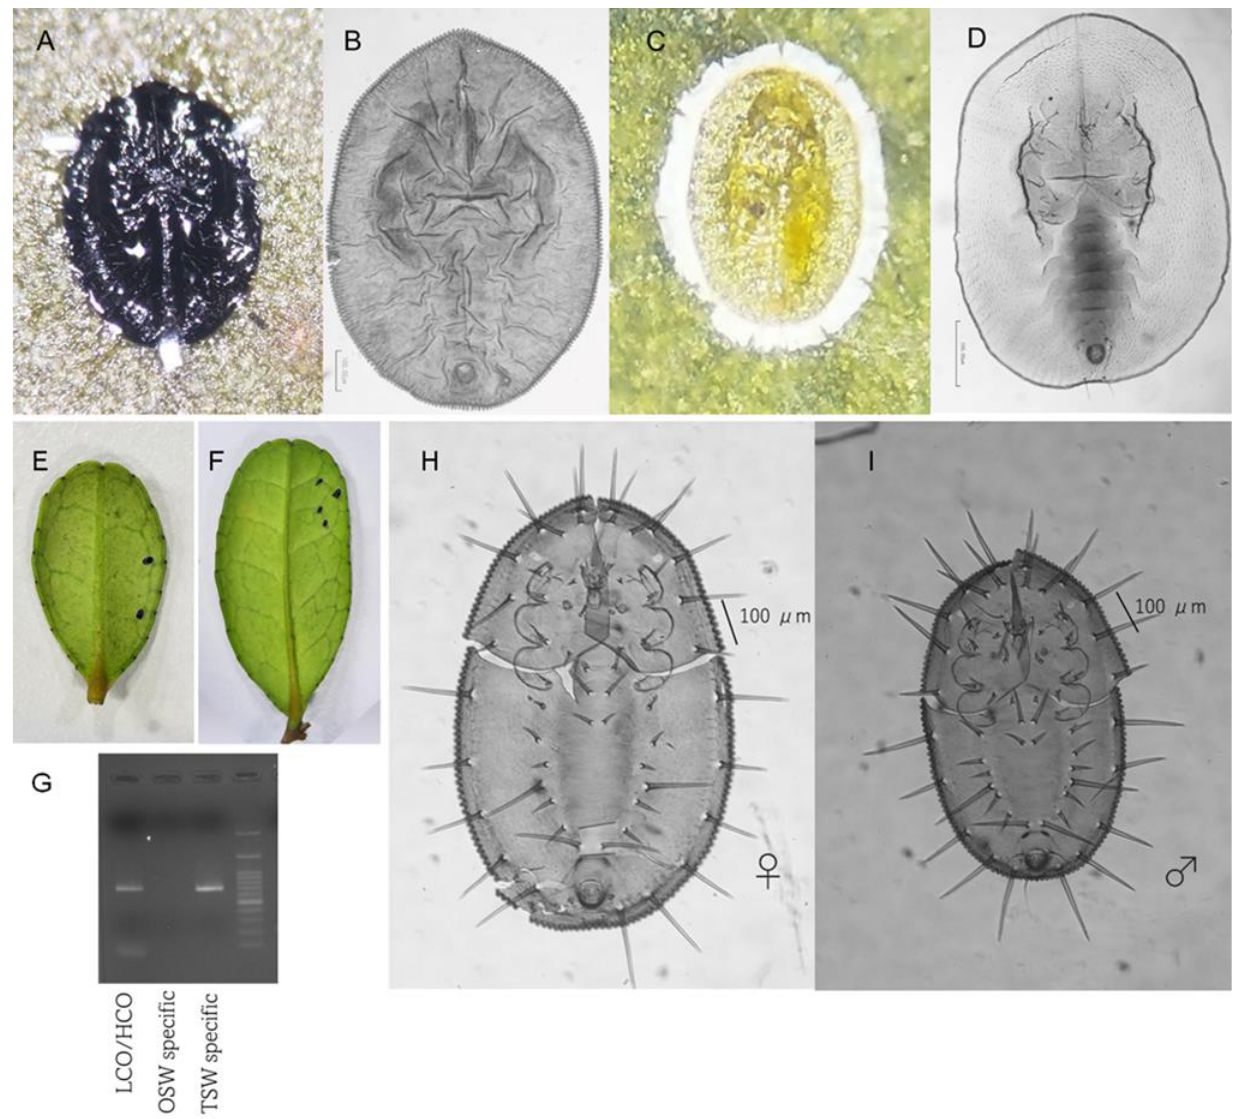
Figure 2. The Aleurocanthini samples examined. ( A , B ) Aleurotrachelus camelliae Kuwana, ( A ) habitus; ( B ) puparium slide-mounted); ( C , D ) Crenidorsum ishigakiensis comb. nov., ( C ) habitus; ( B ) puparium slide-mounted; ( E , F ) habitus of whitefly on Eu. emarginata leaves, ( E ) nymphs for molecular identification, ( F ) exuviae for slides-mounted, ( G ) PCR visualization of general and specific mtCOI primers [60,61] ( H , I ) dimorphism of Aleurocanthus aff. A. camelliae , ( H ) female puparium slide-mounted, ( I ) male puparium slide-mounted.